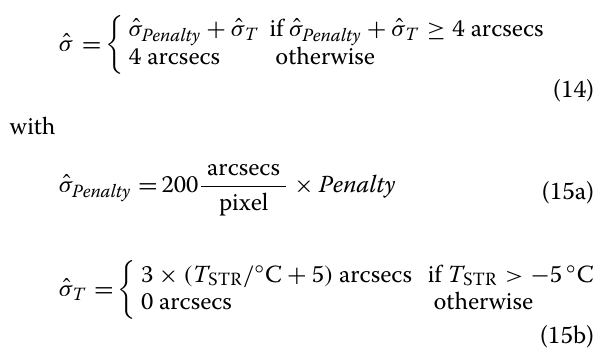
Step 3 is the actual computation of the combined atti- tude solution which is done in the same manner as for the Swarm mission. Basically, the method merges the corrected attitudes from the STRs providing valid atti- σ < 255 arcsecs by rotating the single tude data for which ˆ STR attitudes and their anisotropic covariance matrices σ into the CRF and solving a weighted least- weighted by ˆ squares problem. The thus computed combined attitude quaternion q j 2000 is assigned a scalar uncertainty